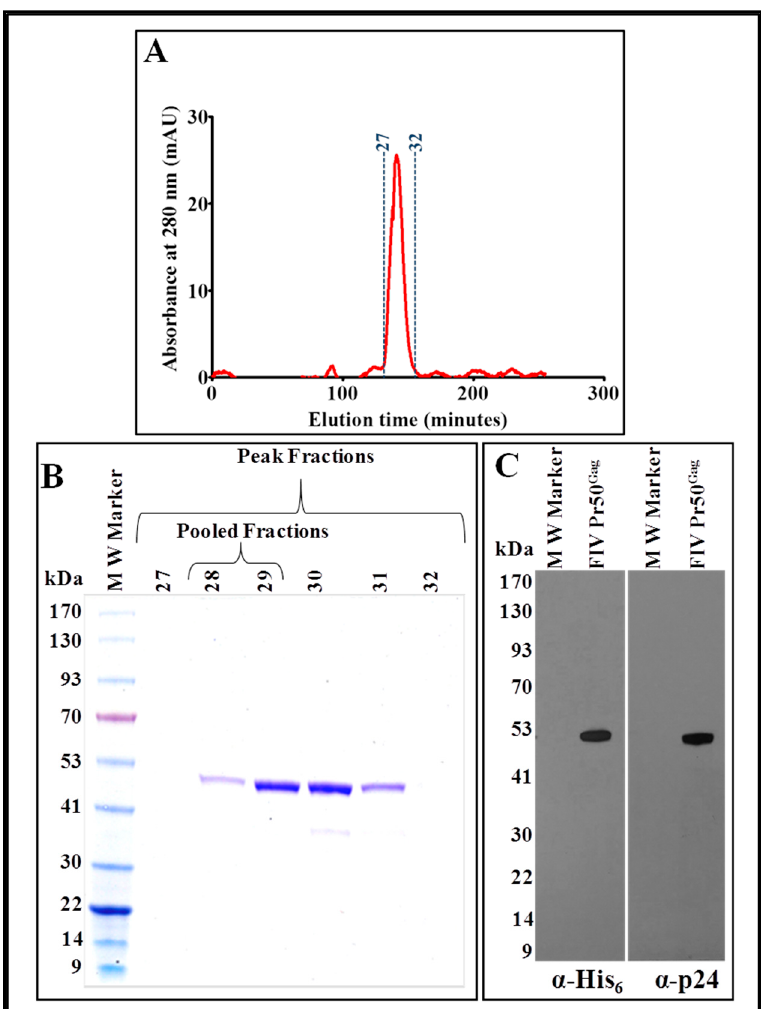
Figure 8. Size exclusion chromatography and western blot analysis of the IMAC-purified recombinant Pr50 Gag -His 6 -tag protein. ( A ) Chromatogram showing a distinct peak (between fractions 27 and 32) of the purified recombinant full-length FIV Pr50 Gag -His 6 -tag fusion protein. ( B ) Coomassie Brilliant Blue-stained SDS-PAGE following electrophoresis of fractions 27–32, which reveals the presence of the purest form of the recombinant full-length FIV Pr50 Gag -His 6 -tag fusion protein in fractions 28 and 29. ( C ) Western blot analyses on the pooled fractions (fractions 28 and 29) of the purified protein using α -His 6 and FIV α -p24 monoclonal antibodies, respectively, using equal amounts of protein.